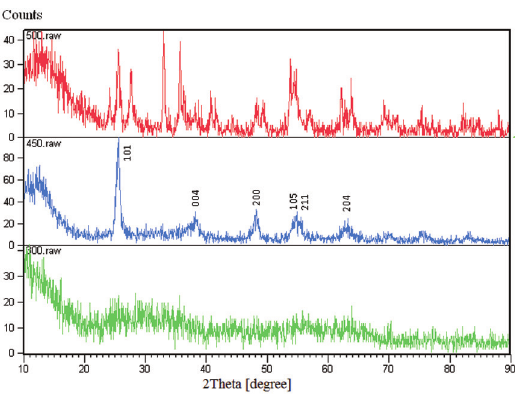
Figure 1: The X-ray diffraction patterns for the Co doped TiO treated at different